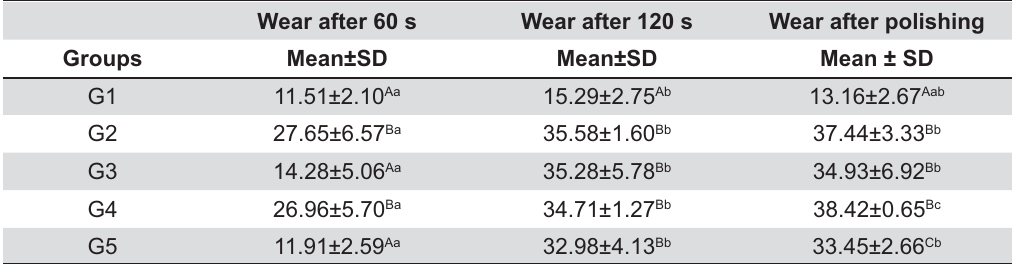
Different lower case letters indicate differences between columns and different capital letters indicate differences between rows